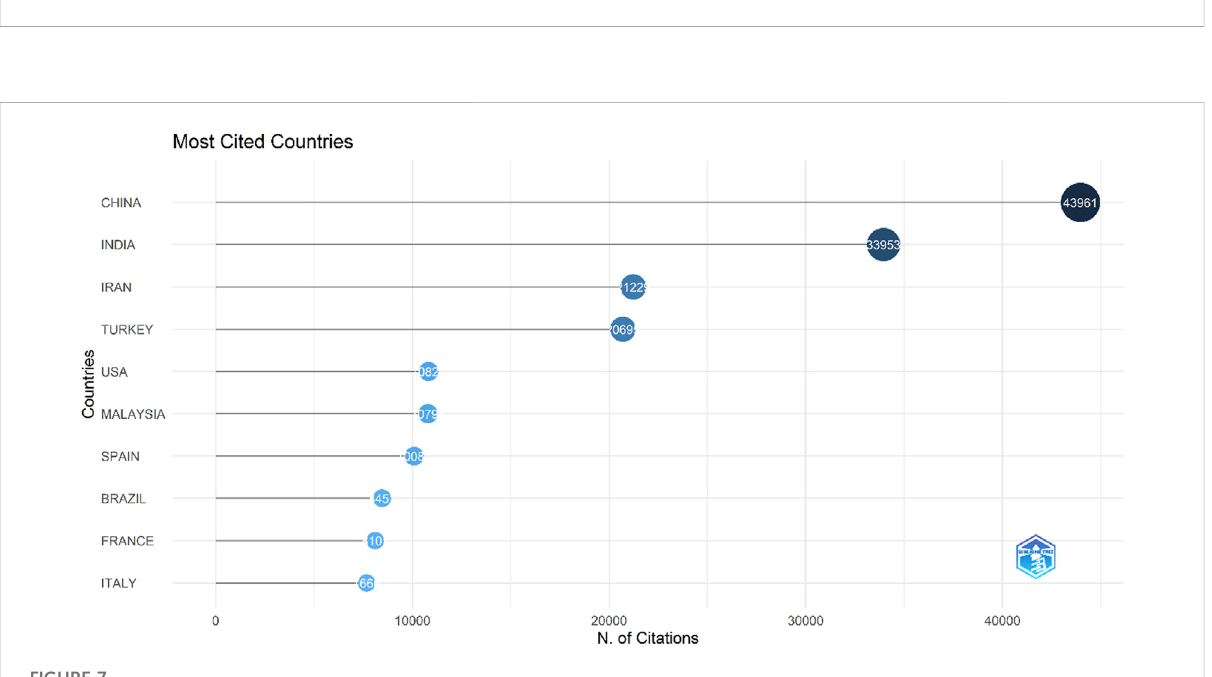
FIGURE 6 Correspondingauthor ’ scountry.Thex-axisindicatesthenumberofdocumentspublished,whilethey-axisindicatesthecountryname.Thetop 10 countries are shown here based on the number of